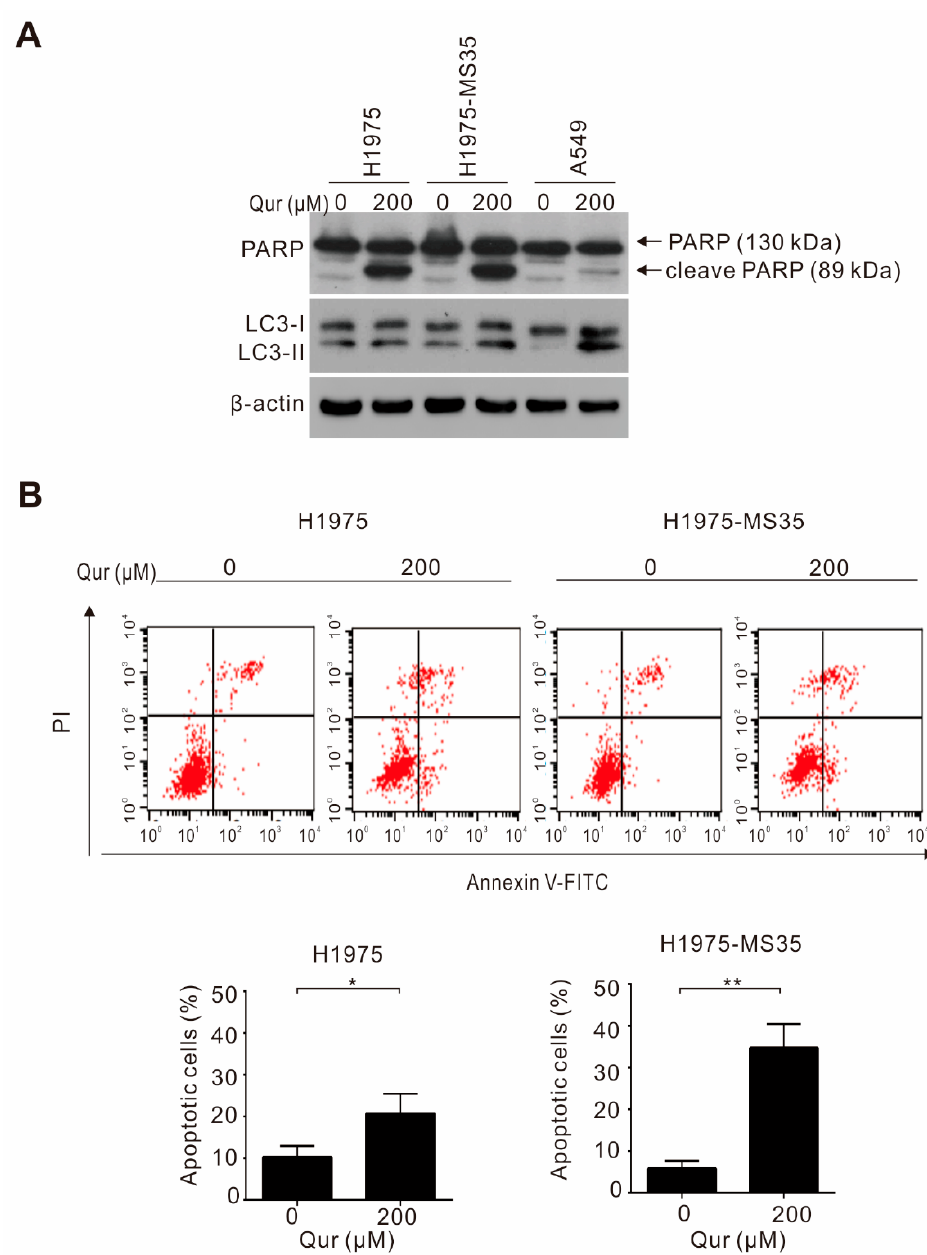
Figure 2. Effects of quercetin on apoptosis and autophagy induction in NSCLC cells. ( A ) NSCLC cells were treated with quercetin for 24 h. The levels of LC3-I, LC3-II, and cleaved PARP (cl-PARP) were determined by Western blotting. β -Actin served as the loading control. ( B ) H1975 and H1975-MS35 cells were treated with quercetin for 24 h, and the induction of apoptosis was assayed by the detection of phosphatidylserine exposure with Annexin V-FITC using flow cytometry. Symbols: * p < 0.05 and ** p< 0.01, as analyzed by unpaired t -tests. To address whether the inhibition of AXL expression by quercetin in NSCLC is due ined the mRNA expression of AXL and performed protein stability analysis of AXL. As